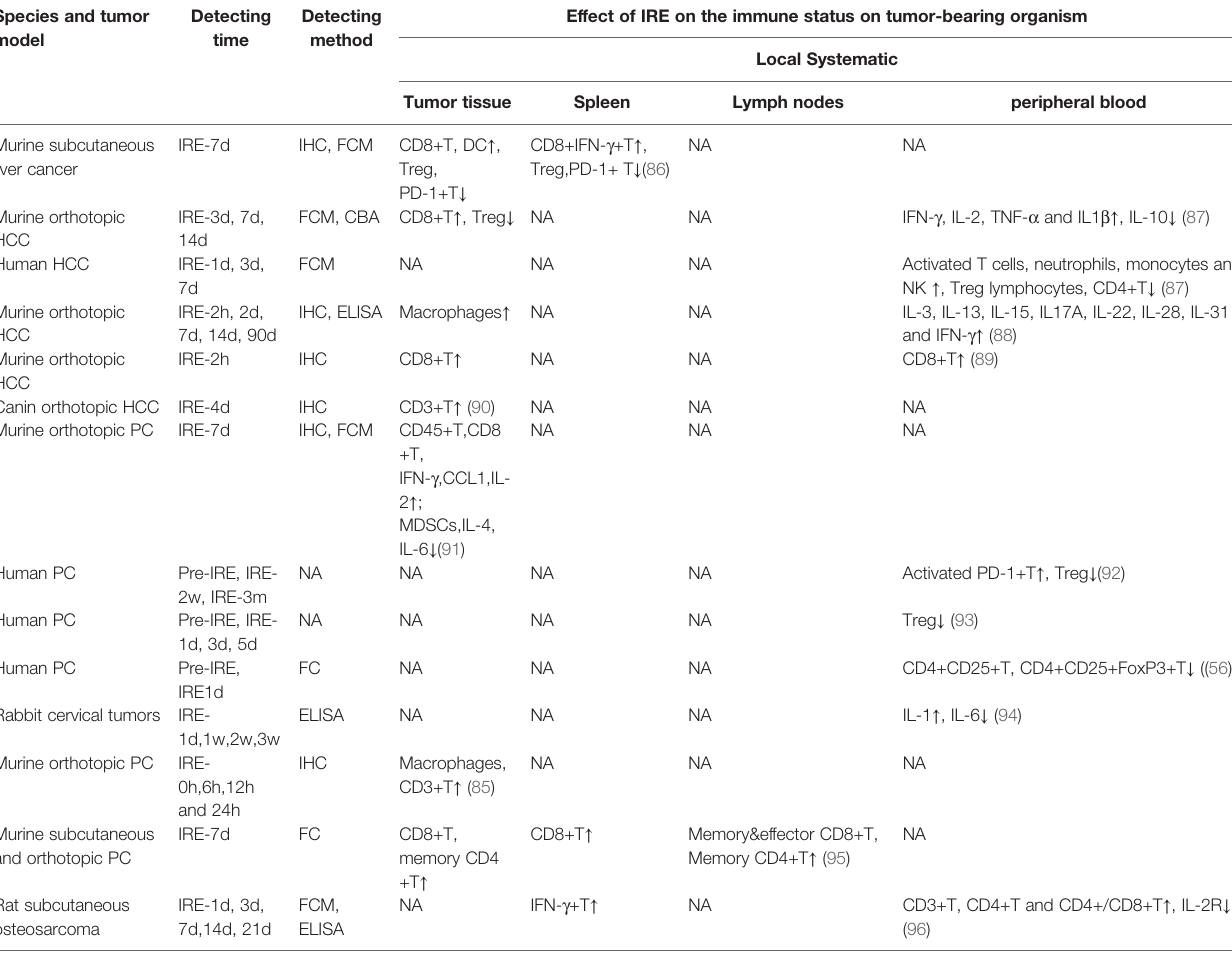
*CBA: Cytometric bead array; ELISA: enzyme linked immunosorbent assay; FCM: fl ow cytometry; IRE: irreversible electroporation; IHC: immunohistochemistry; HCC: hepatocellular carcinoma; NA: not available; PC: pancreatic cancer; ↑ : the cells or cytokines increased after IRE ↓ : the cells or cytokines decreased after